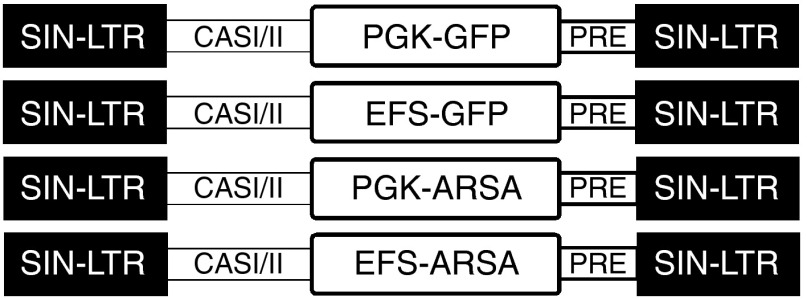
Schematic of foamy virus vectors (FVVs) used in this study. All FVVs contain self-inactivating long-terminal repeats (SIN-LTR, black boxes) with the U3 region deleted of promoter and enhancer activity. The cis-acting sequences I and II (CASI/II) are viral sequences necessary for virion assembly. Promoter and transgene of choice are inserted in a multiple cloning site (large white box). A postregulatory element is included in all constructs to improve transgene expression. ARSA, arylsulphatase A (codon optimized for human expression); EFS, elongation factor 1α short (intron-less version); GFP, enhanced green fluorescent protein; PGK, murine phosphoglycerate kinase promoter.